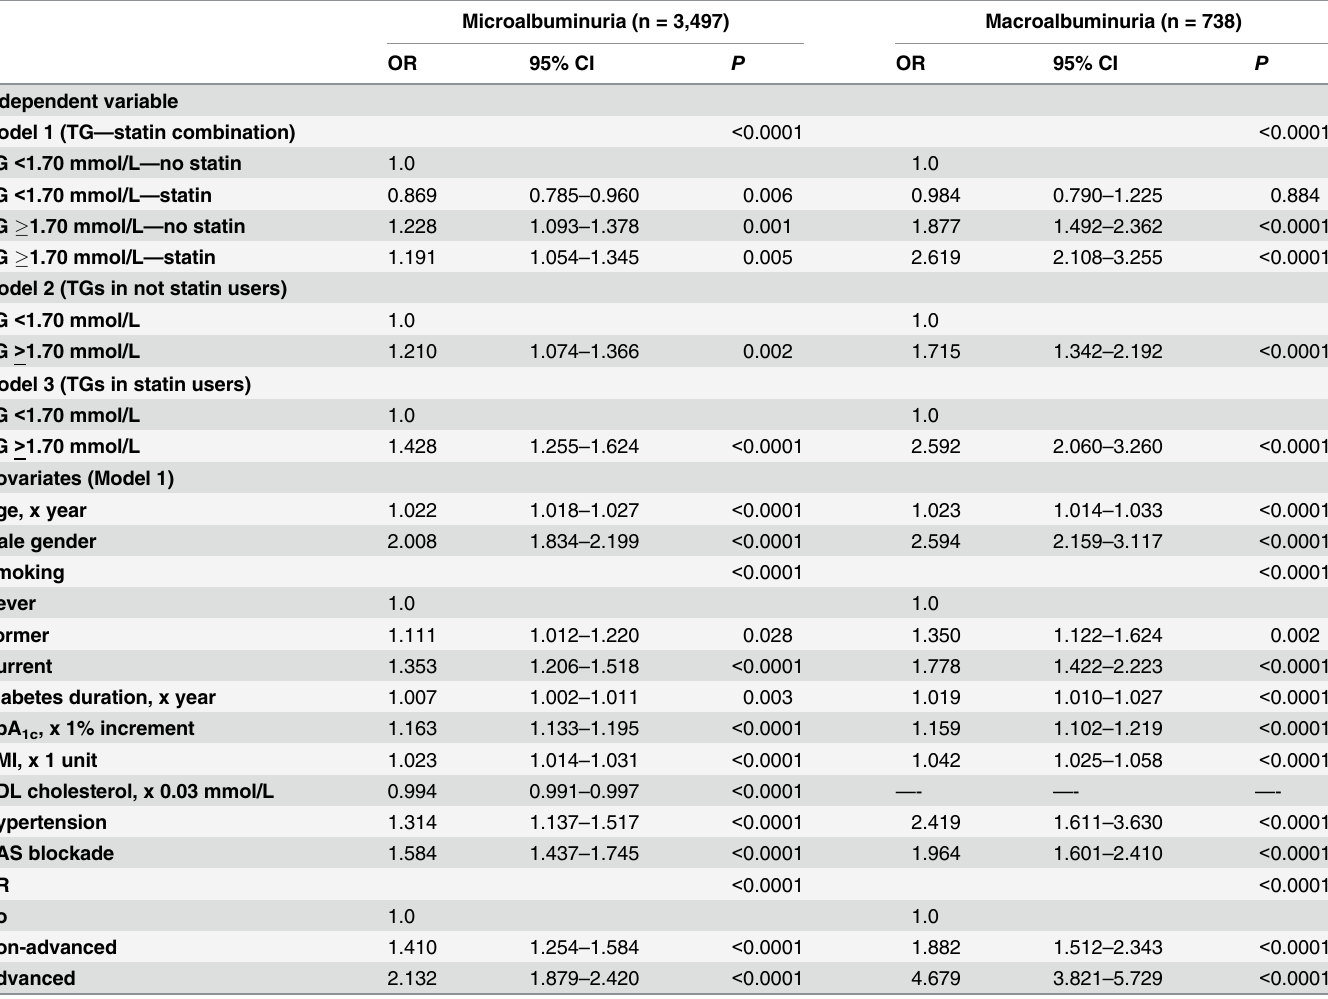
Table 1. Independent association of triglyceride levels and statin treatment with microalbuminuria and macroalbuminuria in the RIACE study.